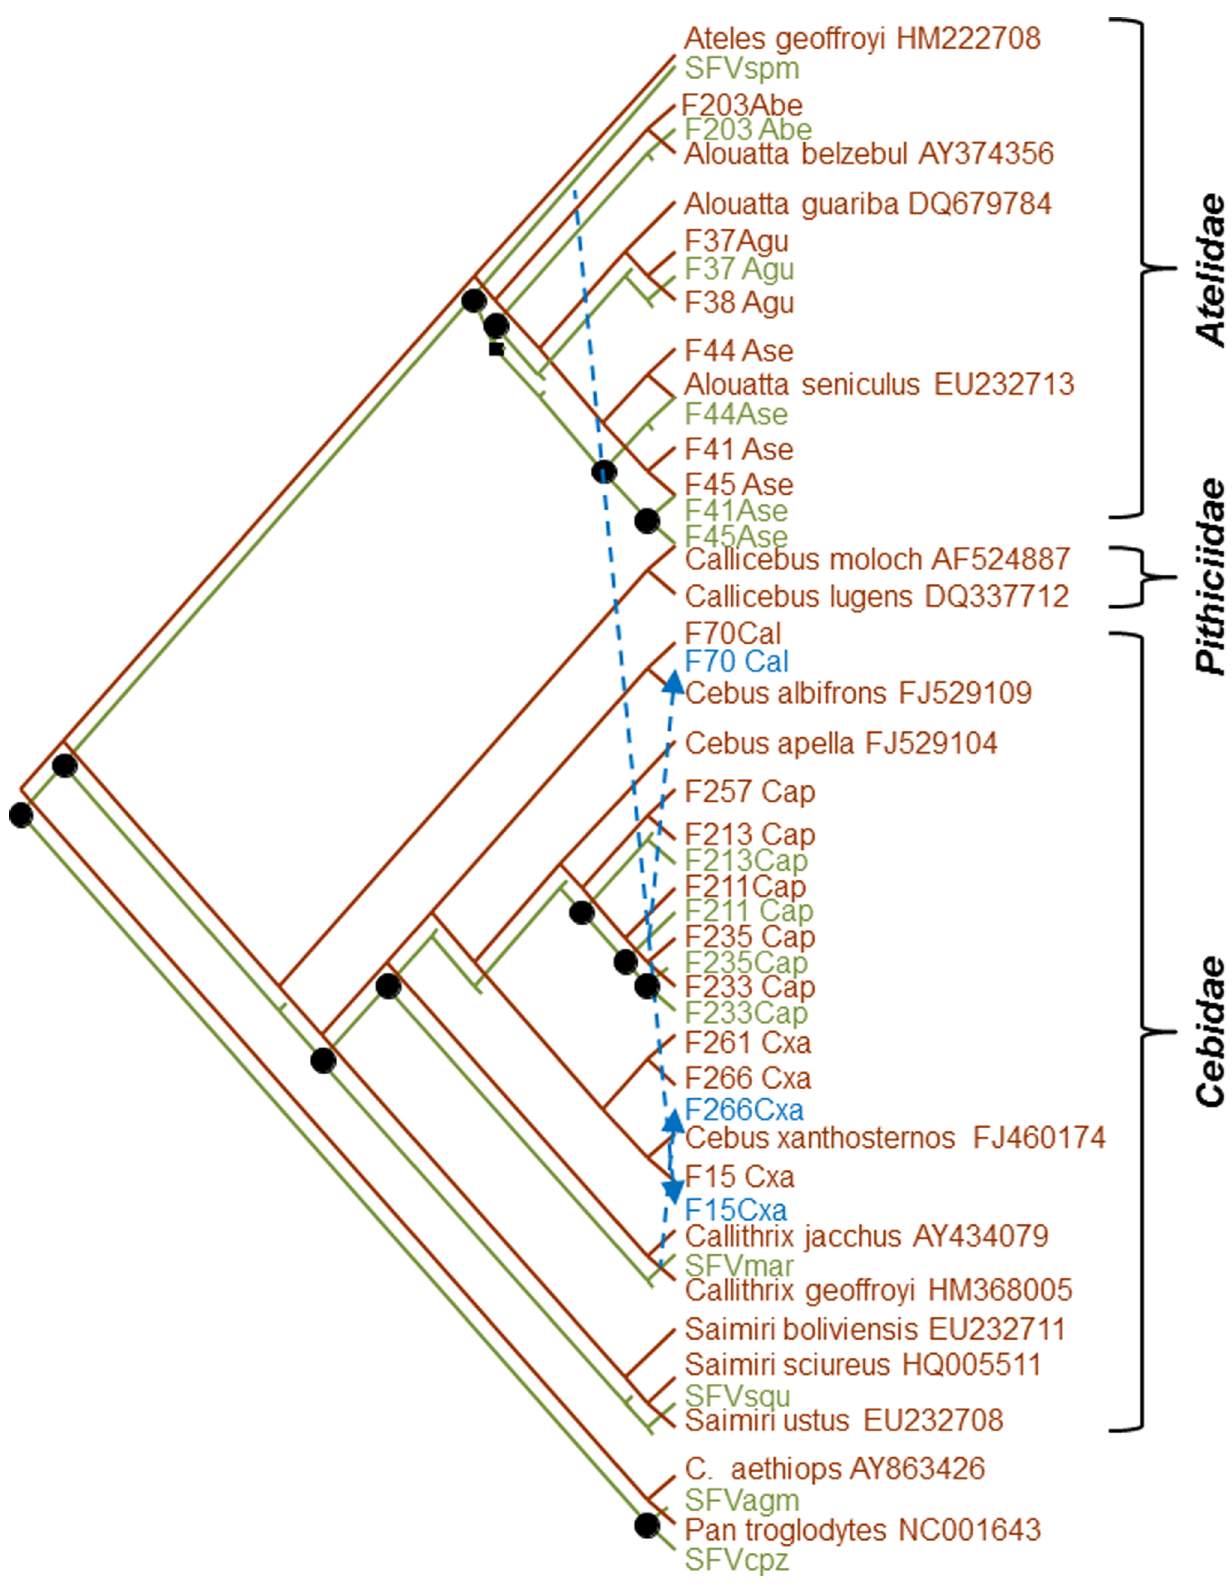
Figure 4. Co-evolutionary relationships of simian foamy virus (SFV) polymerase ( pol ) (green branches and text) and primate cytochrome B ( cytB ) (brown branches and text) Bayesian-inferred phylogenetic trees based on reconciliation analysis. One of nine potentially optimal reconciled trees with 12 cospeciations (black circles), three host switches (blue arrows with dashed lines), 1 duplication (black square), and 15 sorting events (truncated branches without corresponding taxa). doi:10.1371/journal.pone.0067568.g004 PLOS ONE | www.plosone.org 9 July 2013 | Volume 8 | Issue 7 |